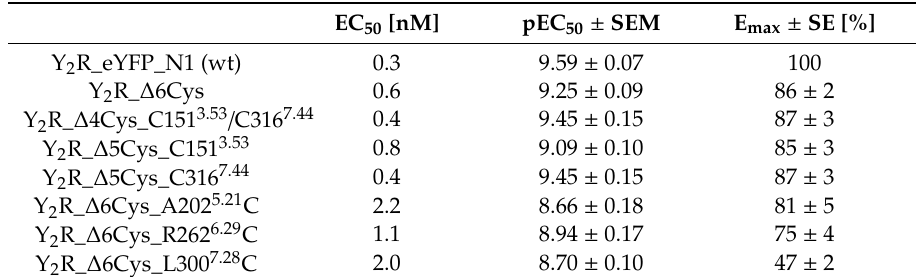
Figure 3. G protein activation of the Y 2 R variants: Receptor activity was determined by inositol phosphate accumulation. COS7 cells were transiently co-transfected with the respective receptor construct and the chimeric G αΔ 4qi6myr protein and labeled with 3 [H]-myo-inositol. All receptor variants were stimulated with NPY for 90 min and accumulated ³H-inositol phosphates were isolated by anion-exchange chromatography. The response was normalized to the wt Y 2 R. Data represent mean ± SEM of n ≥ 2 independent experiments each performed in technical duplicate. Table 1. Compilation of the determined EC 50 , pEC 50 and E max values from the concentration-response curves of the Y 2 R variants.